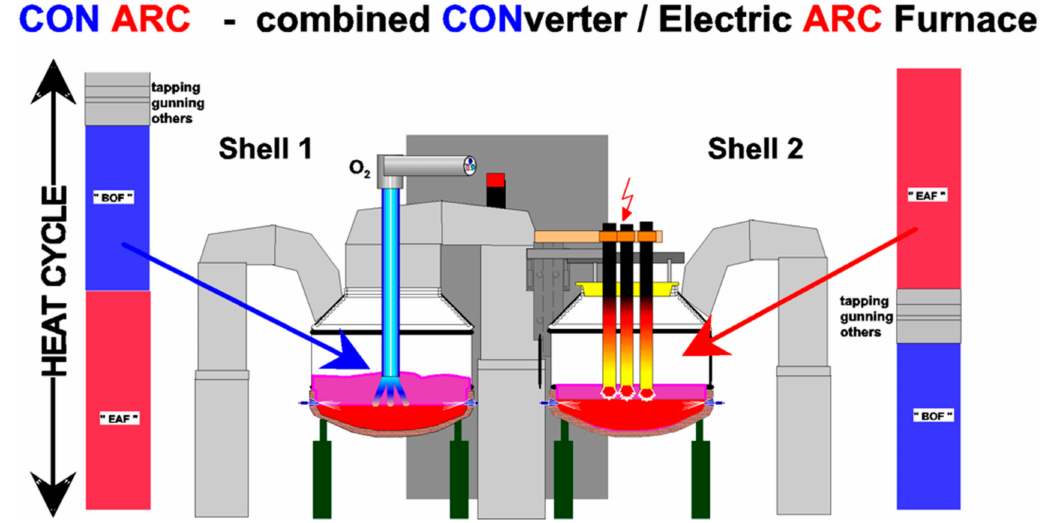
Figure 16. Process concept of CONARC. Reprinted with permission from Ref. [73], 2022, SMS Group